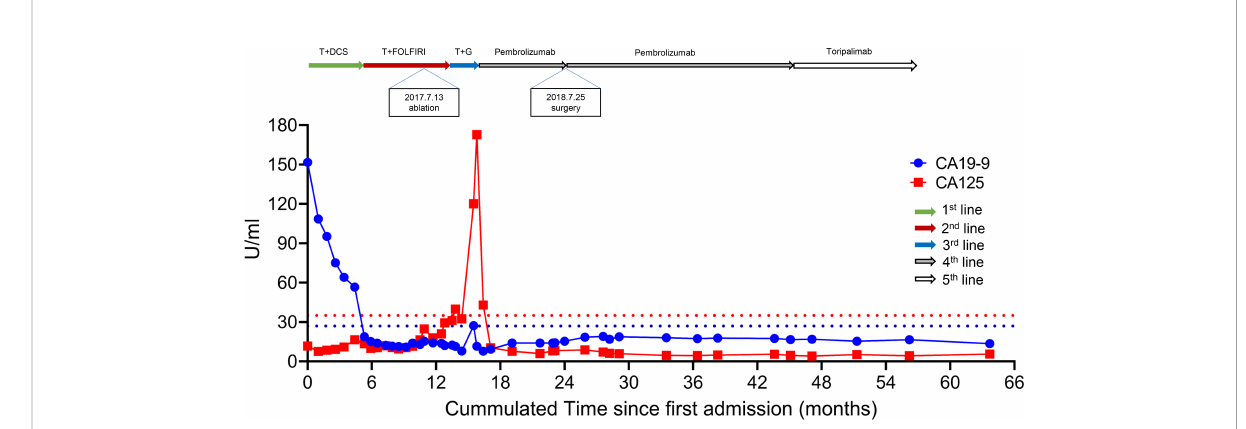
FIGURE 4 Dynamics of cancer antigen 19-9/125 levels during the entire disease course. T, Trastuzumab; DCS, docetaxel + cisplatin+S-1; FOLFIRI, folinic acid + fl uorouracil +